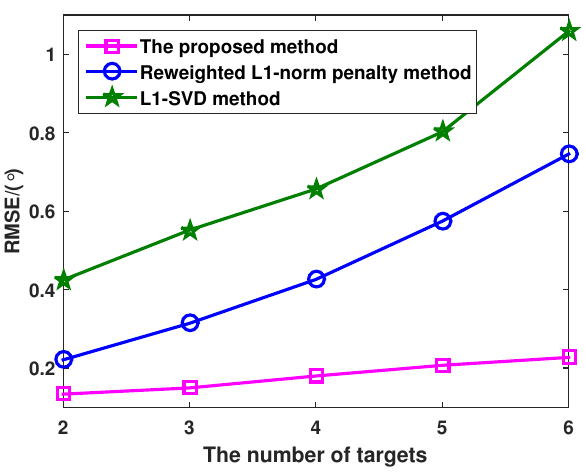
Figure 6. RMSE of the l 1 -SVD method, the reweighted l 1 -norm penalty method and the proposed method versus the number of targets.